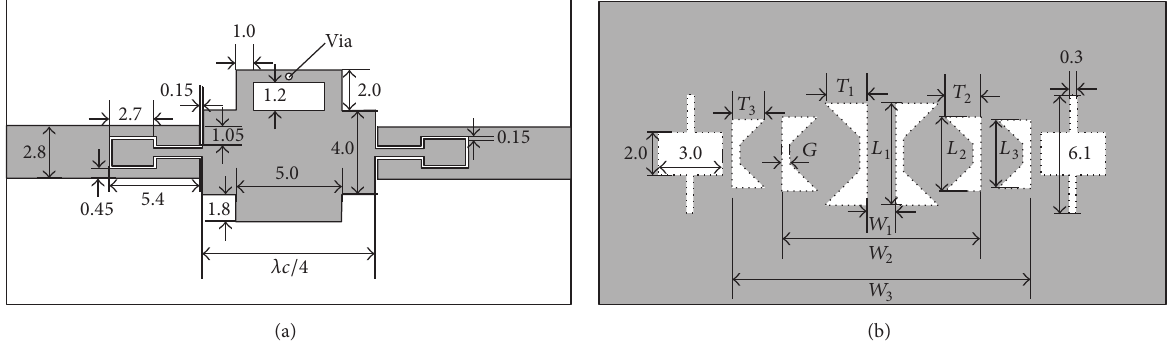
Figure 21: Schematic of UWB BPF [64]. (a) Top view. (b) Bottom view.